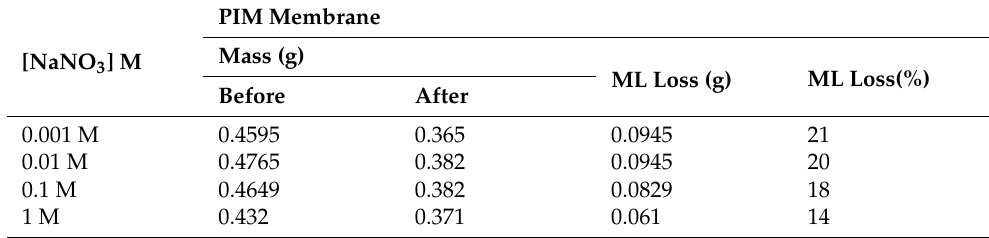
Table 4. Membrane liquid (ML) loss in the presence of NaNO 3 in the receiving phase.